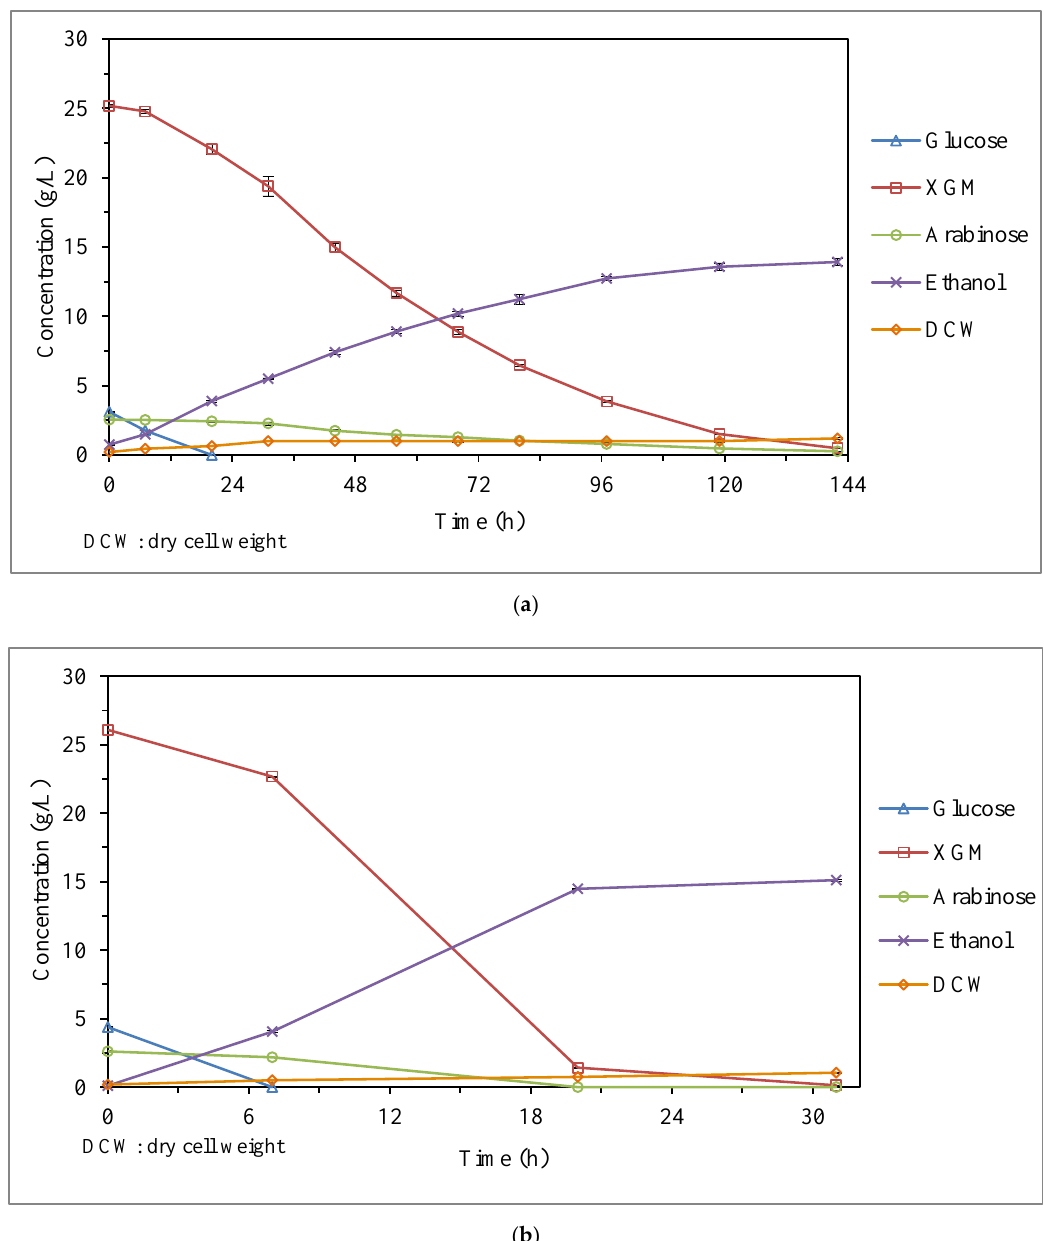
Figure 1. Fermentation of exhausted olive pomace (EOP) hydrolysate by Escherichia coli after ( a ) overliming and ( b ) activated charcoal detoxification.